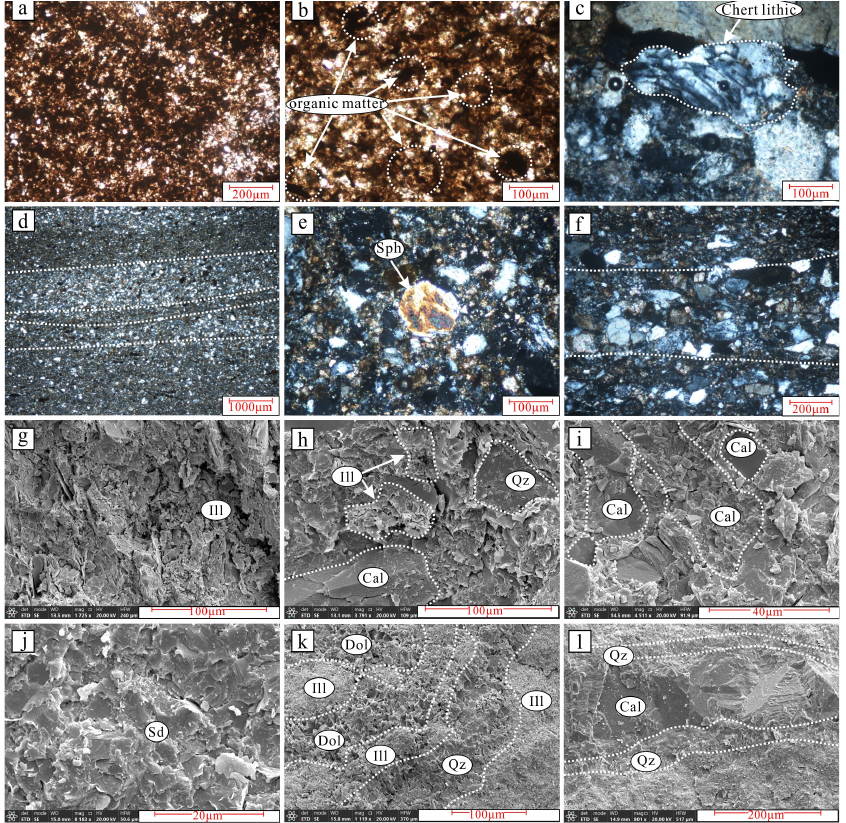
Figure 3. Micro characteristic chart of fine-grained sedimentary rock. Ill: Illite; Cal: Calcite; Sd: Siderite; Qz: Quartz; Dol: Dolomite; Sph: Sphere. ( a ) JH-30, muddy; ( b ) JH-20, argillaceous and organic matter; ( c ) JH-7, flint flake; ( d ) JH-5, silty grain layer; ( e ) JH-3, sphene; ( f ) JH-3, sphene; ( g ) JH-2, illite clay mineral; ( h ) JH-4, calcite crystals and lamellar illite filled intergranular pores, lamellar illite interspersed with mud crystals of silica; ( i ) JH-6, Mud–crystal calcite crystal aggregates filled between relatively well-formed calcite crystals; ( j ) JH-22, mud crystal structure of rhodochrosite crystal assemblage with tight mosaic contact between rhodochrosite crystals; ( k ) JH-8, dolomite crystal aggregates and siliceous aggregates in a fine vein-like distribution; ( l ) JH-23, fine-grained structured calcite crystal aggregate in the form of fine veins, calcite veins flanked by siliceous veins.